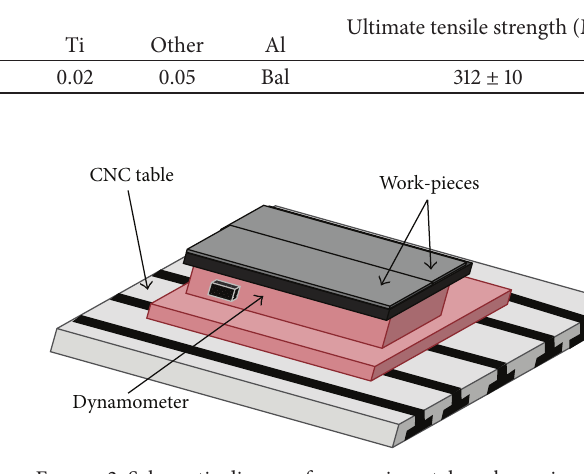
Figure 2: Schematic diagram for experimental work requirements.